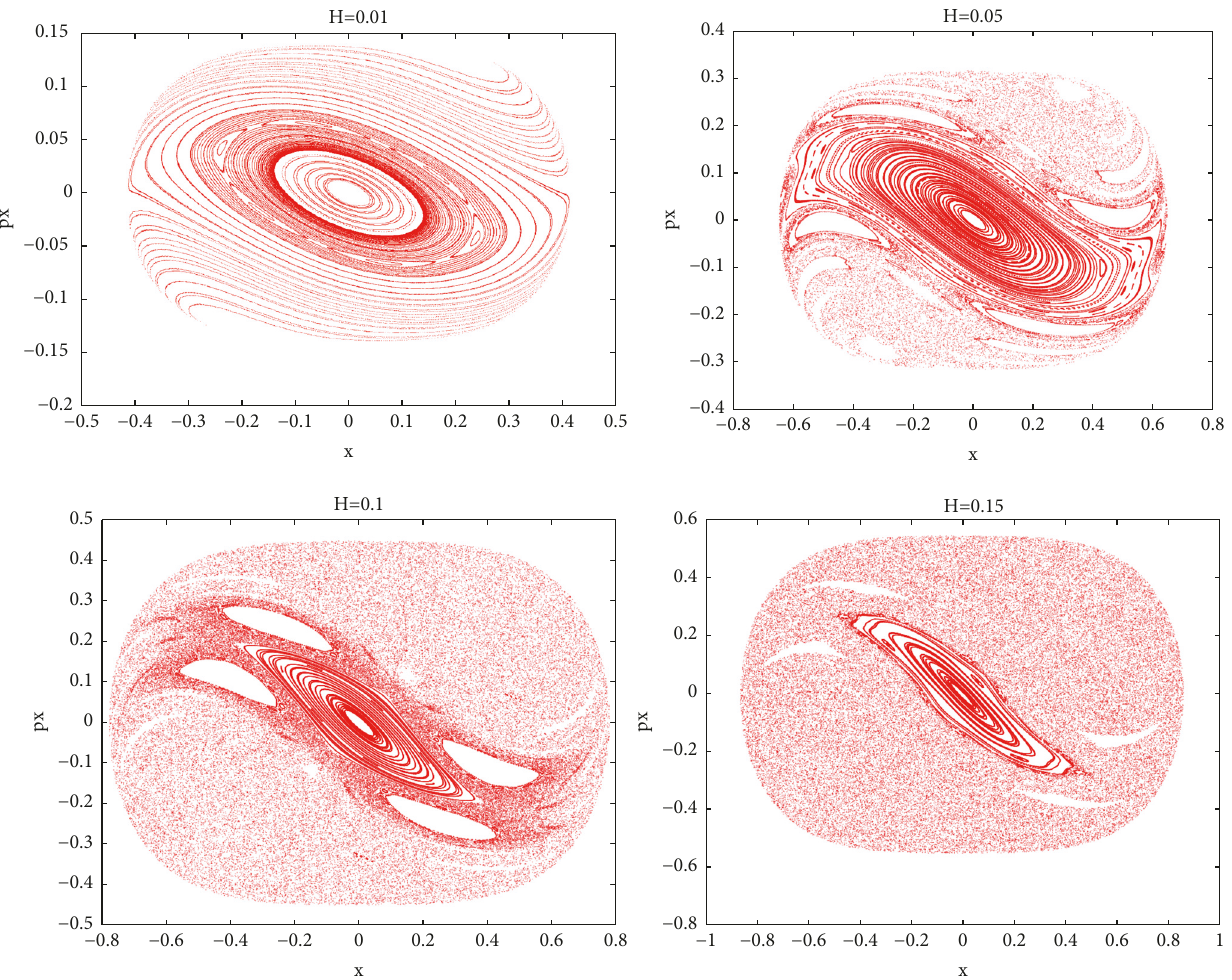
Figure 1: The Poincar´e cross sections of the Nelson Hamiltonian system on the surface 𝑦 = 0.01 when 𝜇 = 0.05